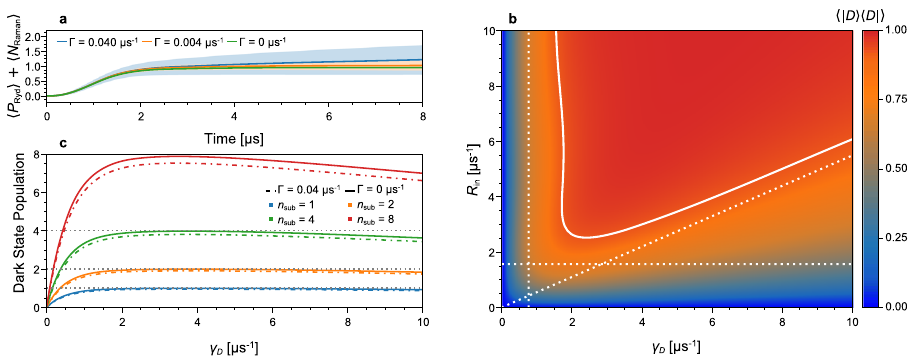
Fig. 4 Theory prediction for the superatom dynamics. All fi gures are at κ = 0.35 μ s − 1 . a Total number of subtracted photons vs. time, i.e. the sum of the dark-state population and Raman emitted photons, for a single superatom at R in = 5 photons μ s − 1 and dephasing rate γ D = 2.4 μ s − 1 . Shaded regions indicate one standard deviation of the number of Raman emitted photons. b Dark-state population, here equal to the photon absorption probability, after driving a single superatom for τ = 3 μ s without Raman decay Γ = 0. The solid line indicates the 90% level. The dashed horizontal, vertical and diagonal ffiffiffiffiffiffiffiffi p κ R τ ¼ π = 2, exp ð(cid:3) γ τ Þ ¼ 0 : 1 and exp ð(cid:3) 4 κ R τ = γ lines correspond to Þ ¼ 0 : 1, respectively. c Mean dark-state population in a chain of 1, 2, 4 and in in D D 8 superatoms after driving the superatoms for τ = 4 μ s at a constant rate of R in = 5 photons μ s −